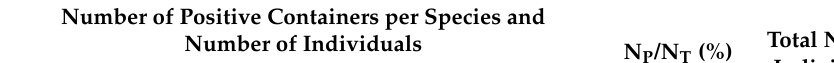
Table 2. Distribution of Aedes aegypti and Aedes albopictus specimens among larval habitats and standing water sources at 18 study sites in